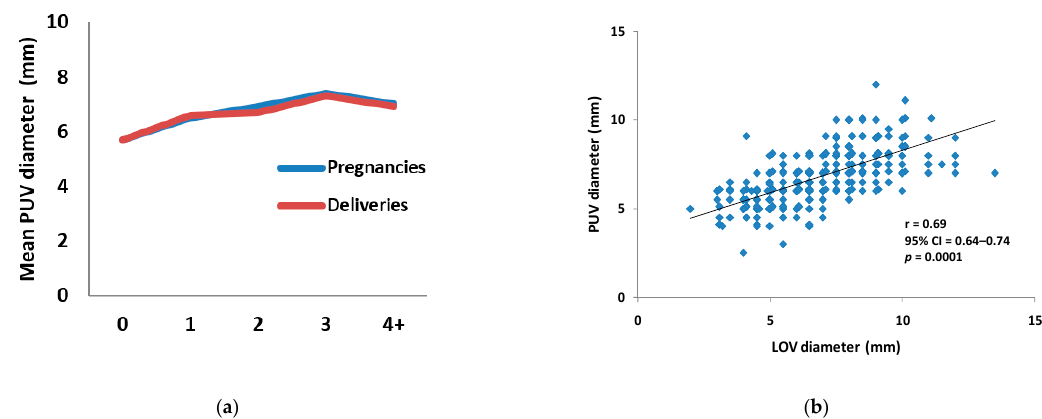
Figure 3. Mean parauterine vein diameter. ( a ) The graph shows the mean diameters (in mm, vertical axis) of parauterine veins with regard to the number of pregnancies or deliveries, respectively (horizontal axis). ( b ) The graph shows the relationship between the diameters of left ovarian and parauterine veins. Each dot represents the respective measurements from a single individual. Abbreviations: LOV: left ovarian vein, PUV: parauterine veins, and “4+”: 4 or more.